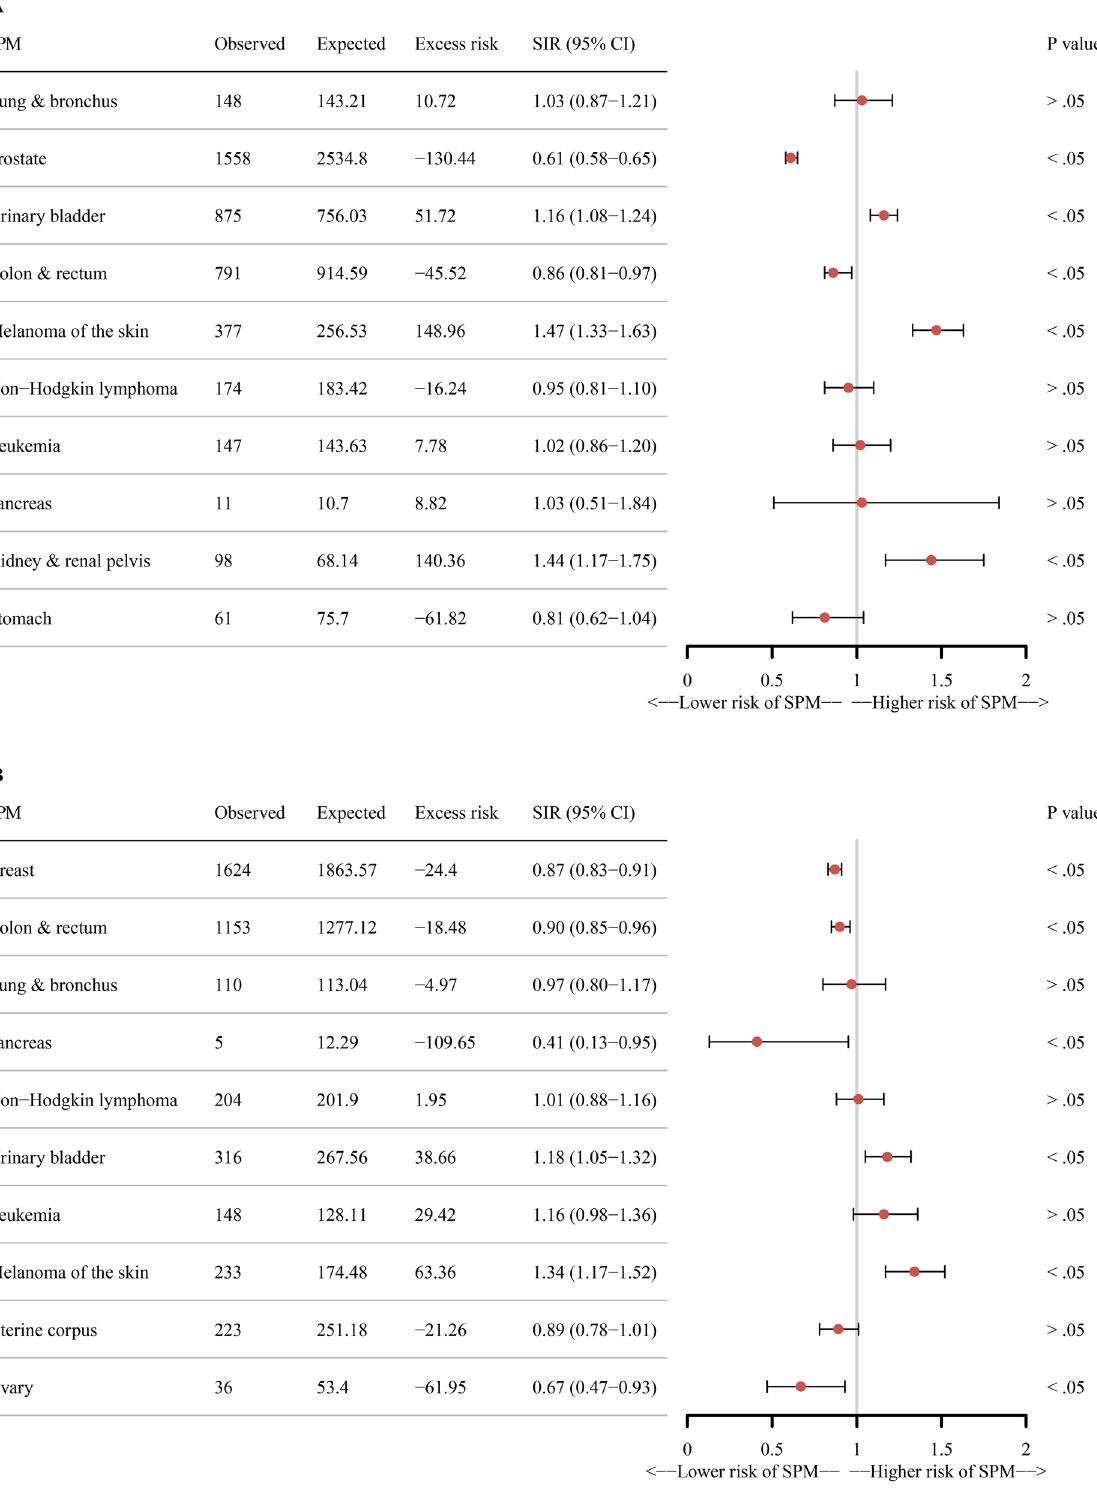
Figure 1. SIRs and 95% CIs for SPM in cancer survivors aged 85 years and older. ( A ) Male patients and ( B ) female patients. The ten leading primary cancer types in males and females aged 85 years and older were selected. The excess risk is per 10,000 persons. SIR > 1.00 indicates a higher risk. SIR, standardized incidence ratio; CI, confidence interval; SPM, second primary malignant